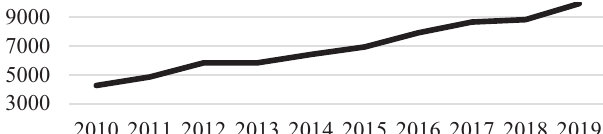
Figure 3. Dynamic of assets (thousand euros) (source: elaborated by the